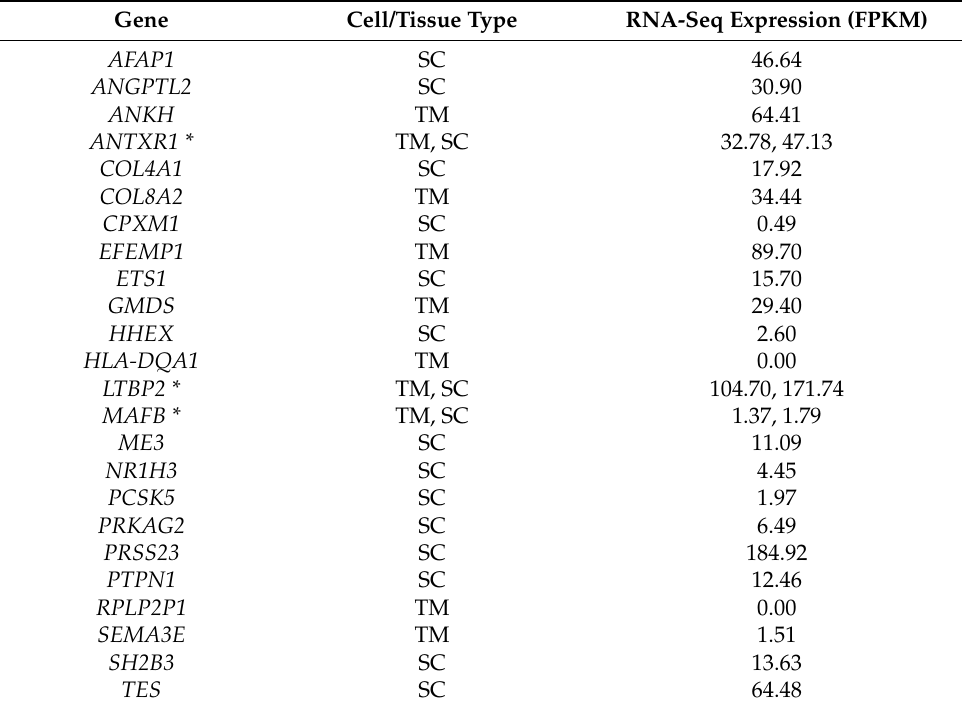
Table 3. Expression of Differentially Expressed Intraocular Pressure-Associated Genes in